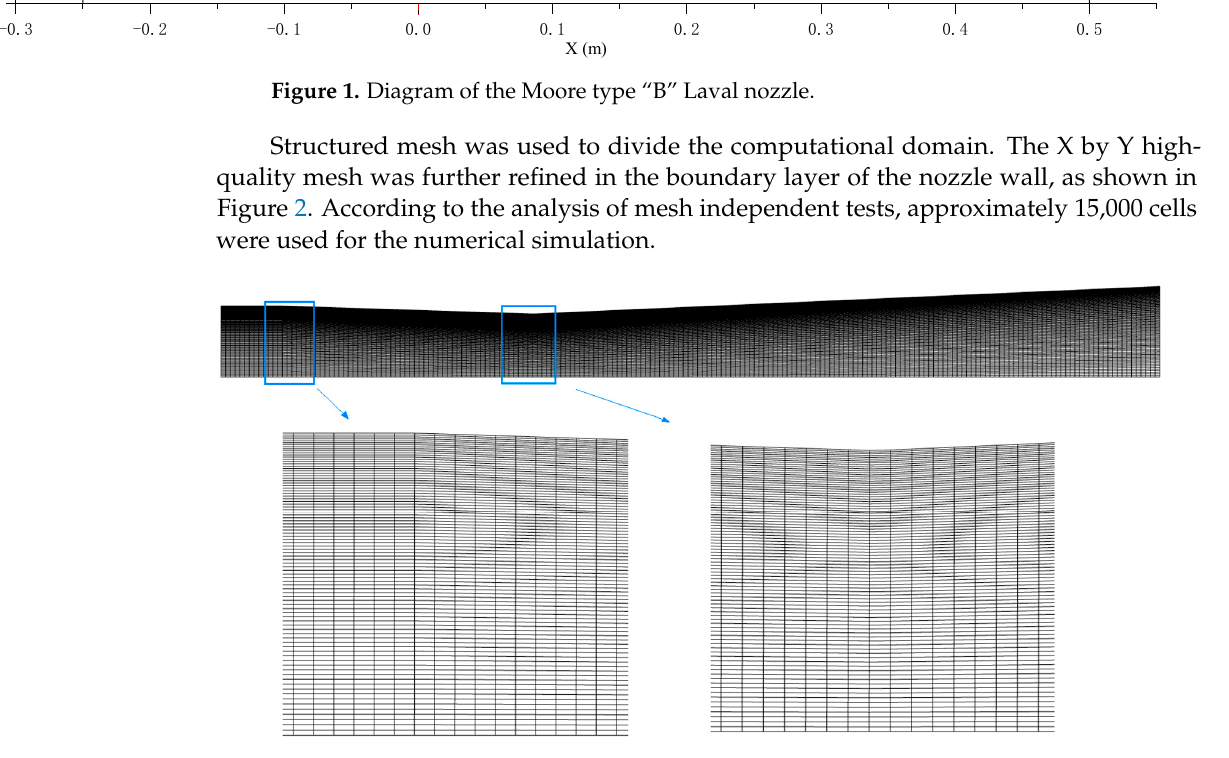
Figure 2. Moore type “B” nozzle meshing.